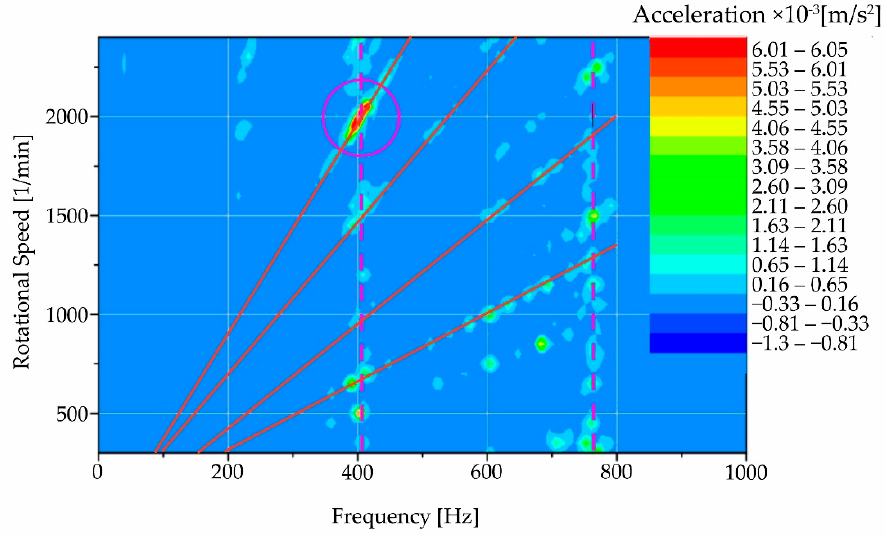
Figure 17. Frequency and speed map for machine start-up with shifted scale. Color maps represent a three-dimensional representation in the frequency-speed plane, with the axis of amplitudes going toward us. Rotating this three-dimensional representation and removing the color map, we obtain a waterfall-type representation (Figure 18). Where the solid red lines again correspond to frequencies (as in Figure 17) that are dependent on the speed of the grinding wheel, and where the solid lines intersect with the dashed line that marks the position of the natural frequencies, resonance occurs.